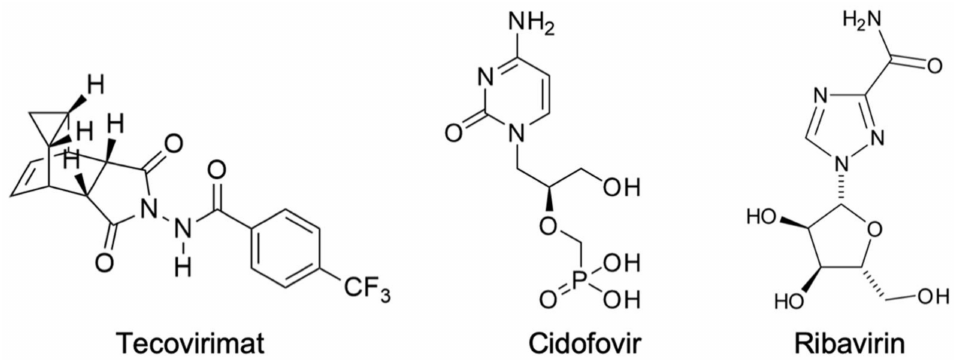
Figure 1. Structures of tecovirimat, cidofovir, and